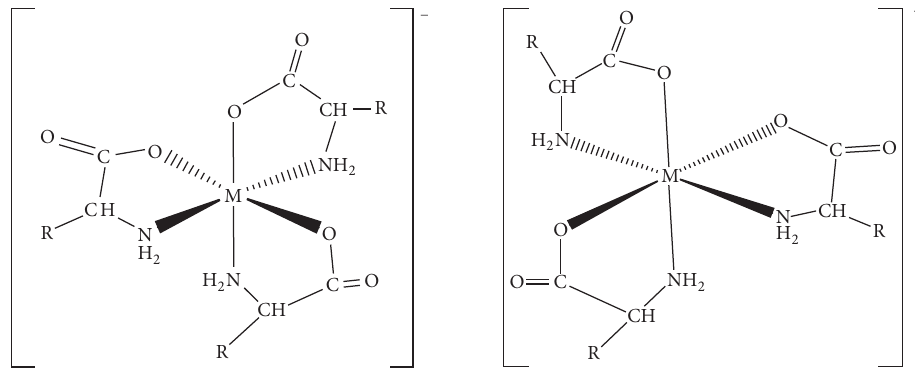
Figure 6: The proposed structure for the optical isomer for the tris-chelate complexes. R: –H; glycinato complexes; –CH 2 COOH; aspartato